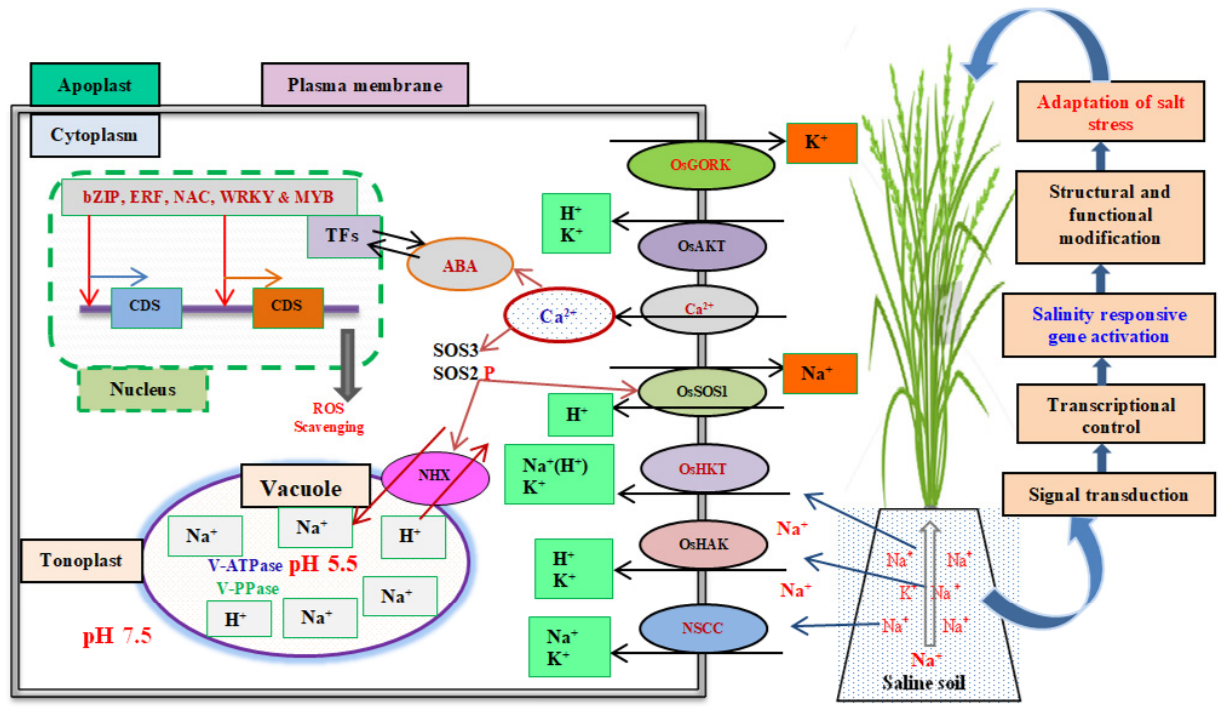
Figure 2. A summary of the ion transport system and adaptive mechanisms of rice under salinity. A schematic diagram of the ion transport system involved in cellular sodium uptake and accumulation in plants; SOS: Na + /H + antiporter, HAK: K + transporter, AKT1: K + transporter, HKT: K + /Na + - symporter or Na + transporter or high-affinity K + transporter, NHX: Na + /H + exchanger, NSCC: non- selective cation channel. The sources of energy during salinity stress are vascular proton-pumping pyrophosphatase (H + -PPase or V-PPase), vacuolar H + -ATPase or V-ATPase: V-type. Ca 2+ -dependent signalling network involves salinity stress response; ABA acts as a major signalling molecule in stress